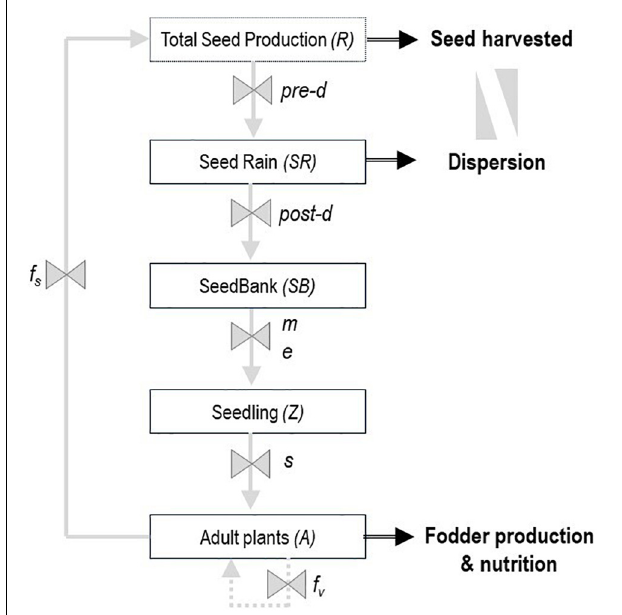
FIGURE 3 | Conceptual model of the life cycle of an annual or perennial pasture biotype. Boxes indicate state in the plant life cycle. Gray arrows indicate the processes, and black arrows the agronomic traits of interest for pre-breeding. Process variables: pre-d, predation pre-dispersal; post-d, predation post-dispersal and seed rain losses; m, mortality of seeds in the soil; e, germination and seedling emergence; s, seedlings survivorship; fs, seed fecundity; and fv, vegetative